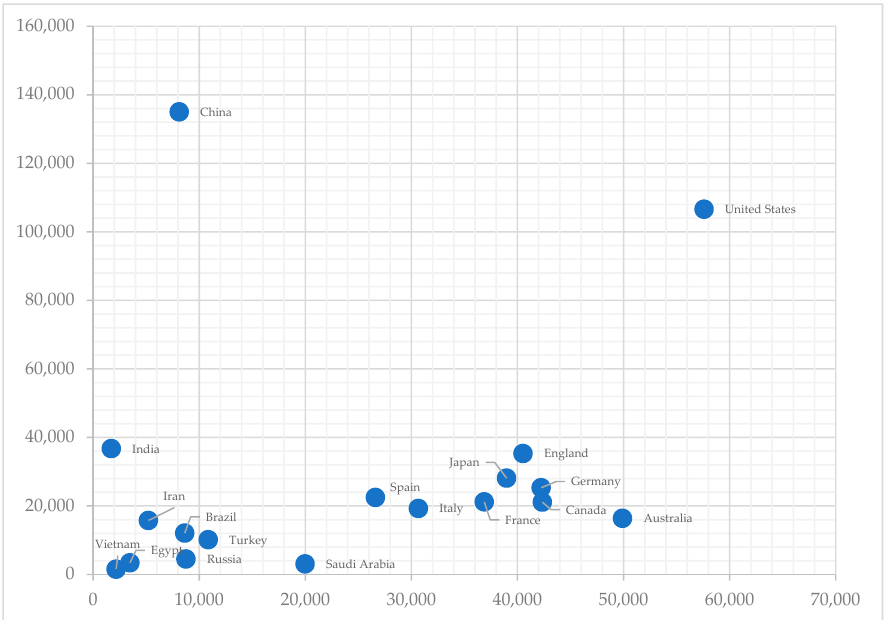
Figure 1. A visualization of the relationship between Gross Domestic Product (GDP) per capita (x-axis; unit: USD) and total publications on AI in the 1998–2017 period (y-axis; unit: publications); data from 18 countries across the economic spectrum were retrieved. Source: Elsevier [39] .